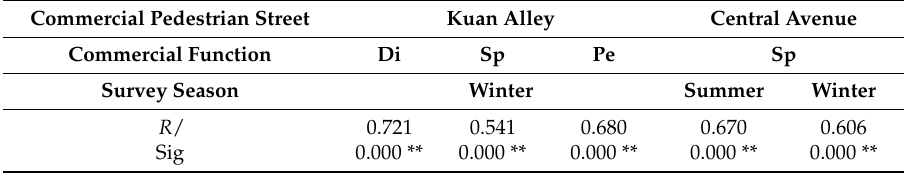
Table 5. The relationship between the number of talkers and the sound pressure level.